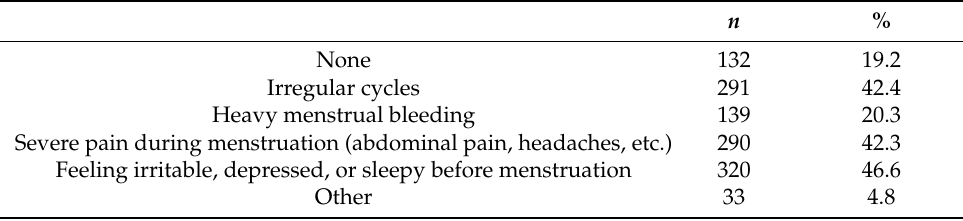
Table 4. Menstruation-related problems among estrogen-like supplement users.